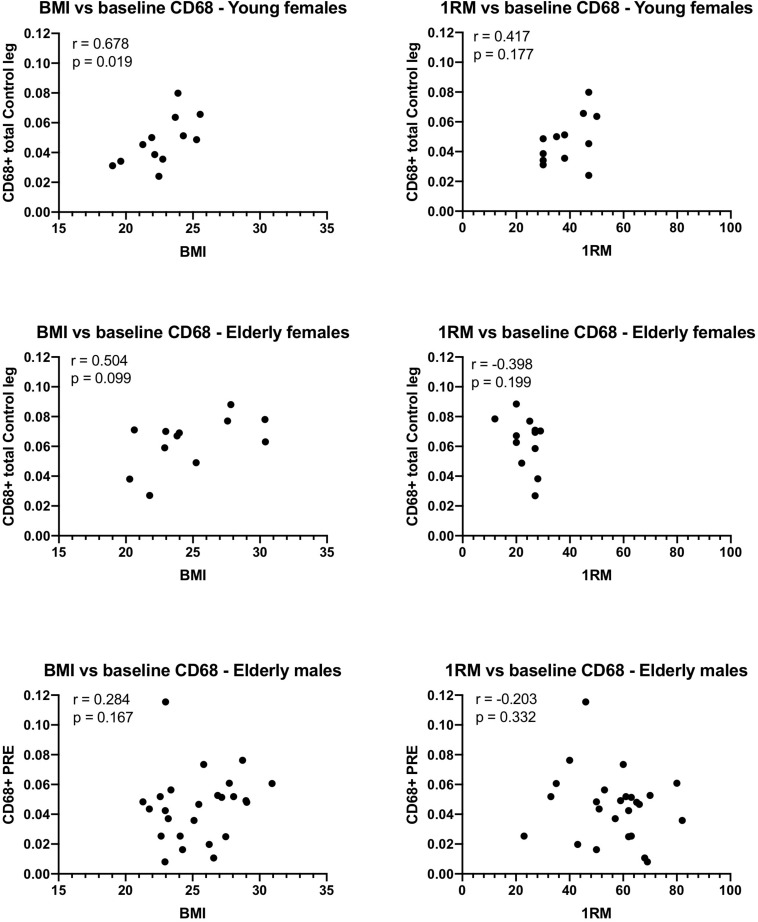
Relationship between body mass index (BMI), or 1-repition maximum (1RM), and the number of CD68 macrophages counted on tissue sections from muscle biopsies obtained from young and elderly females, and elderly males. Spearman’s r and the p-values for the correlation are displayed for each graph. Note that if the potential outlier in the CD68 data of the elderly males is removed, the r value is 0.373 and the p-value 0.073, suggesting a trend.